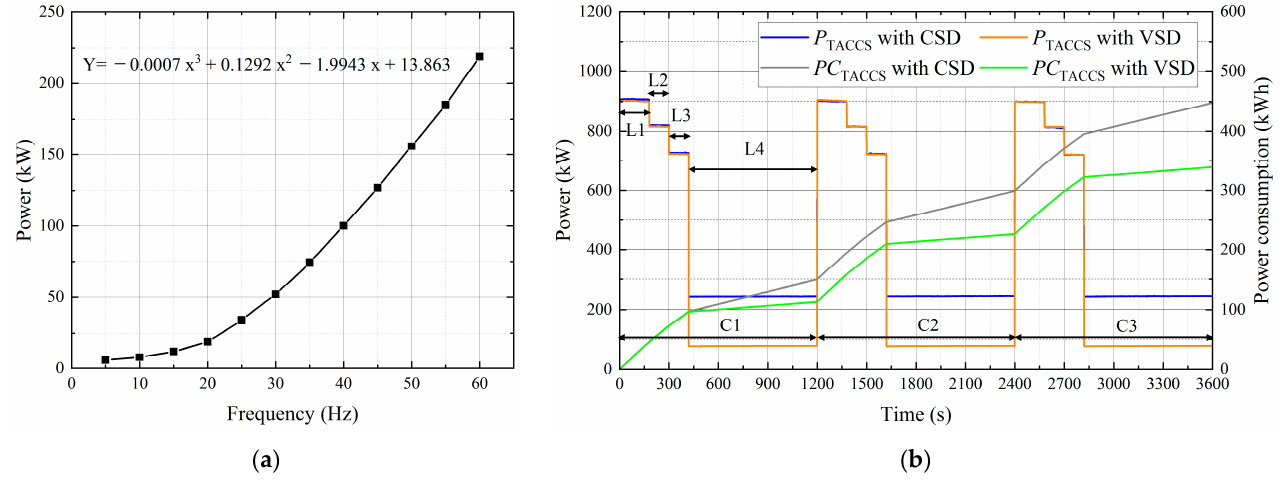
Figure 10. Power consumption curves of the TACCS according to the CSD and VSD. ( a ) Power curve of the TACCS at no load condition; ( b ) comparison of power and power consumption curves .